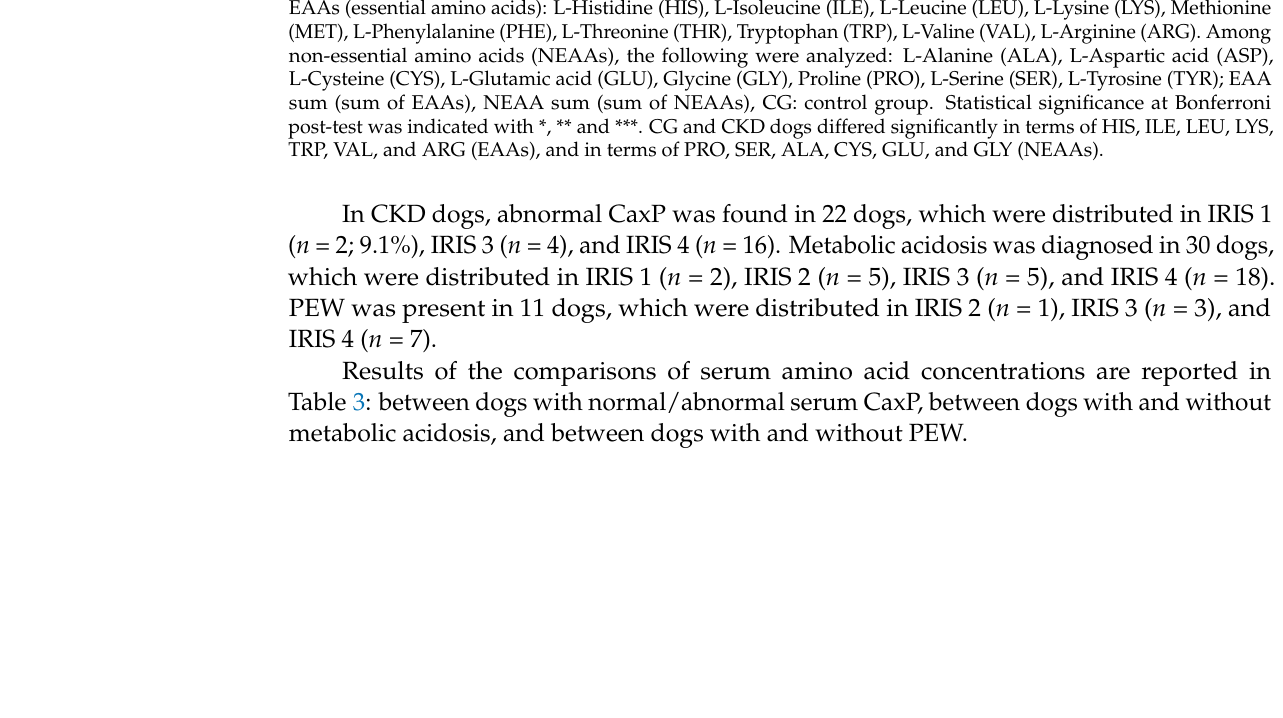
Table 3: between dogs with normal/abnormal serum CaxP, between dogs with and without metabolic acidosis, and between dogs with and without